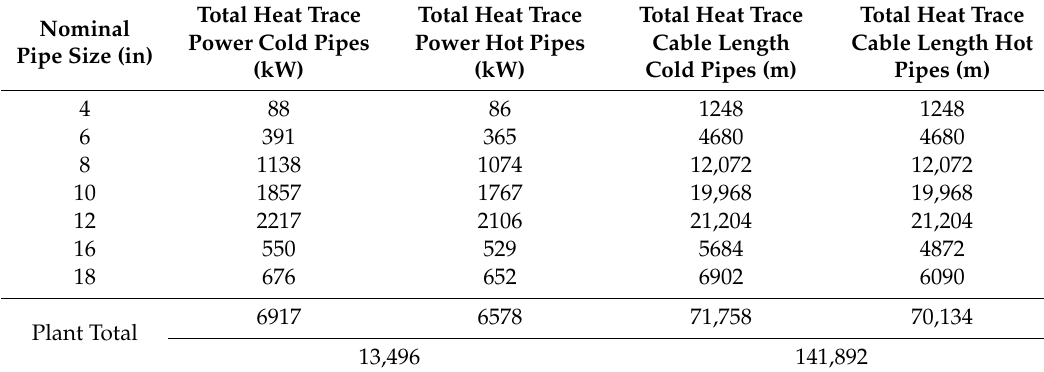
Table 3. Plant heat trace specifications for a Solar Salt-based plant with 388 collector loops.